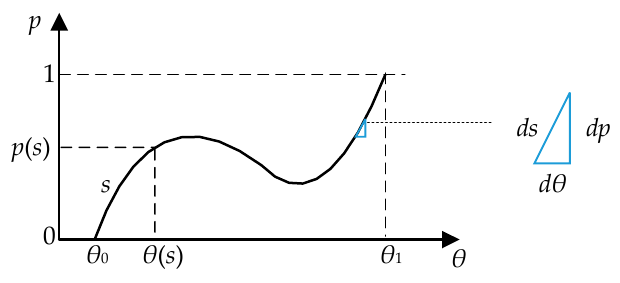
Figure 3. The homotopy curve.